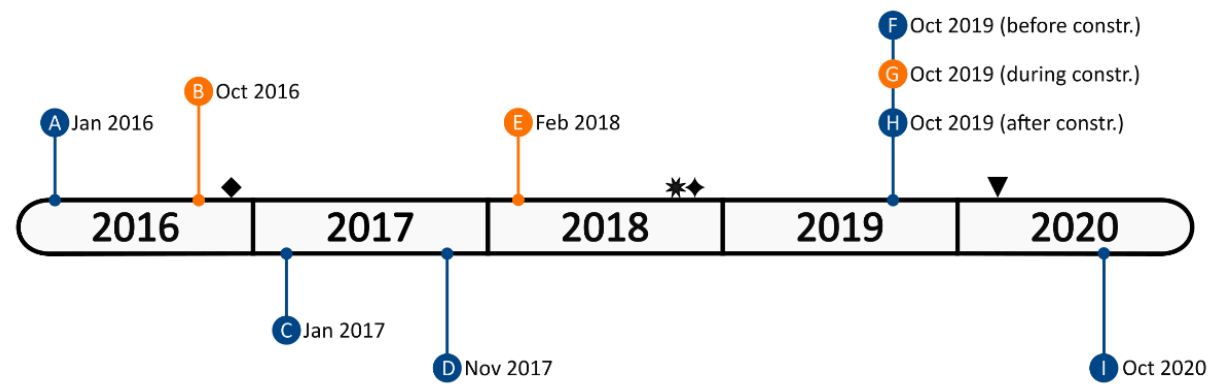
Figure 1. Timeline of all observation periods over the five-year span. All observations that were carried out during construction (B, E, and G) are highlighted in orange. (cid:7) Arnie, Kai, and Noah were transported to other facilities. ✸ Death of Moby. ✦ Arrival of Nynke. ▼ Death of Anke. Table 2. Catalog of behavioral categories that were used during scan sampling. For each behavioral category, some exam- ples are shown.